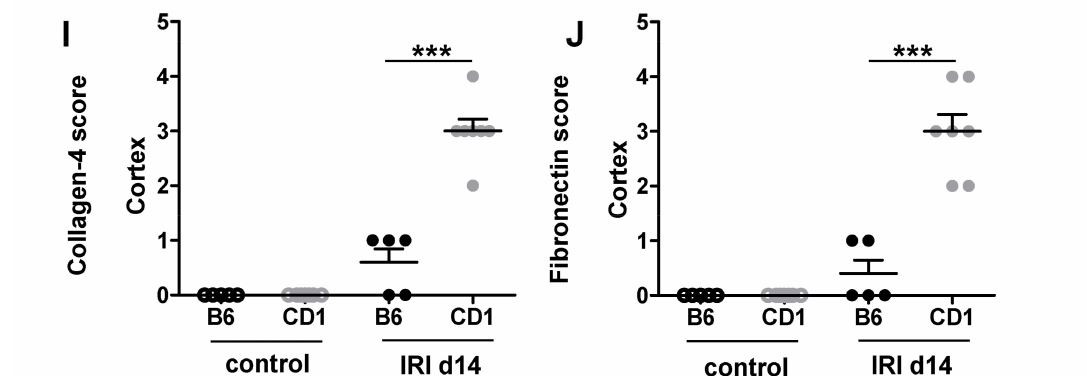
Figure 4. Kidney volume loss was found in both mouse strains 14 days after IRI. Pearson correlation of relative T2 values on d1 ( A ) and relative ADC values on d1 ( B ) are shown. Relative values of medullary ADC and of cortical T2 measured at d1 after surgery correlated significantly with kidney volume loss on d14. Collagen-4 expression (red staining. ( C , E , G )) is pronounced in CD1 ( G ) compared to B6 ( E ) and control ( C ) two weeks after IRI indicating renal fibrosis. Moreover, fibronectin (red staining, ( D , F , H )) as another marker of fibrosis was enhanced at d14 after IRI in CD1 ( H ) compared to B6 ( F ) and control ( D ). Semi-quantative histomorphological scoring of collagen-4 is shown in ( I ) and that of fibronectin in ( J ). The following scoring system has been used: 0 = no fibronectin/collagen-4 deposition; 1 = mild fibronectin/collagen-4 deposition, 2 = moderate fibronectin/collagen-4 deposition, 3 = severe fibronectin/collagen-4 deposition, 4 = very severe fibronectin/collagen-4 deposition. Five to seven mice each group were examined. One-way Anova followed by Tukey’s post-hoc test was used for multiple comparison of the normally distributed data. *** = p < 0.001. Scale bar = 100 µ